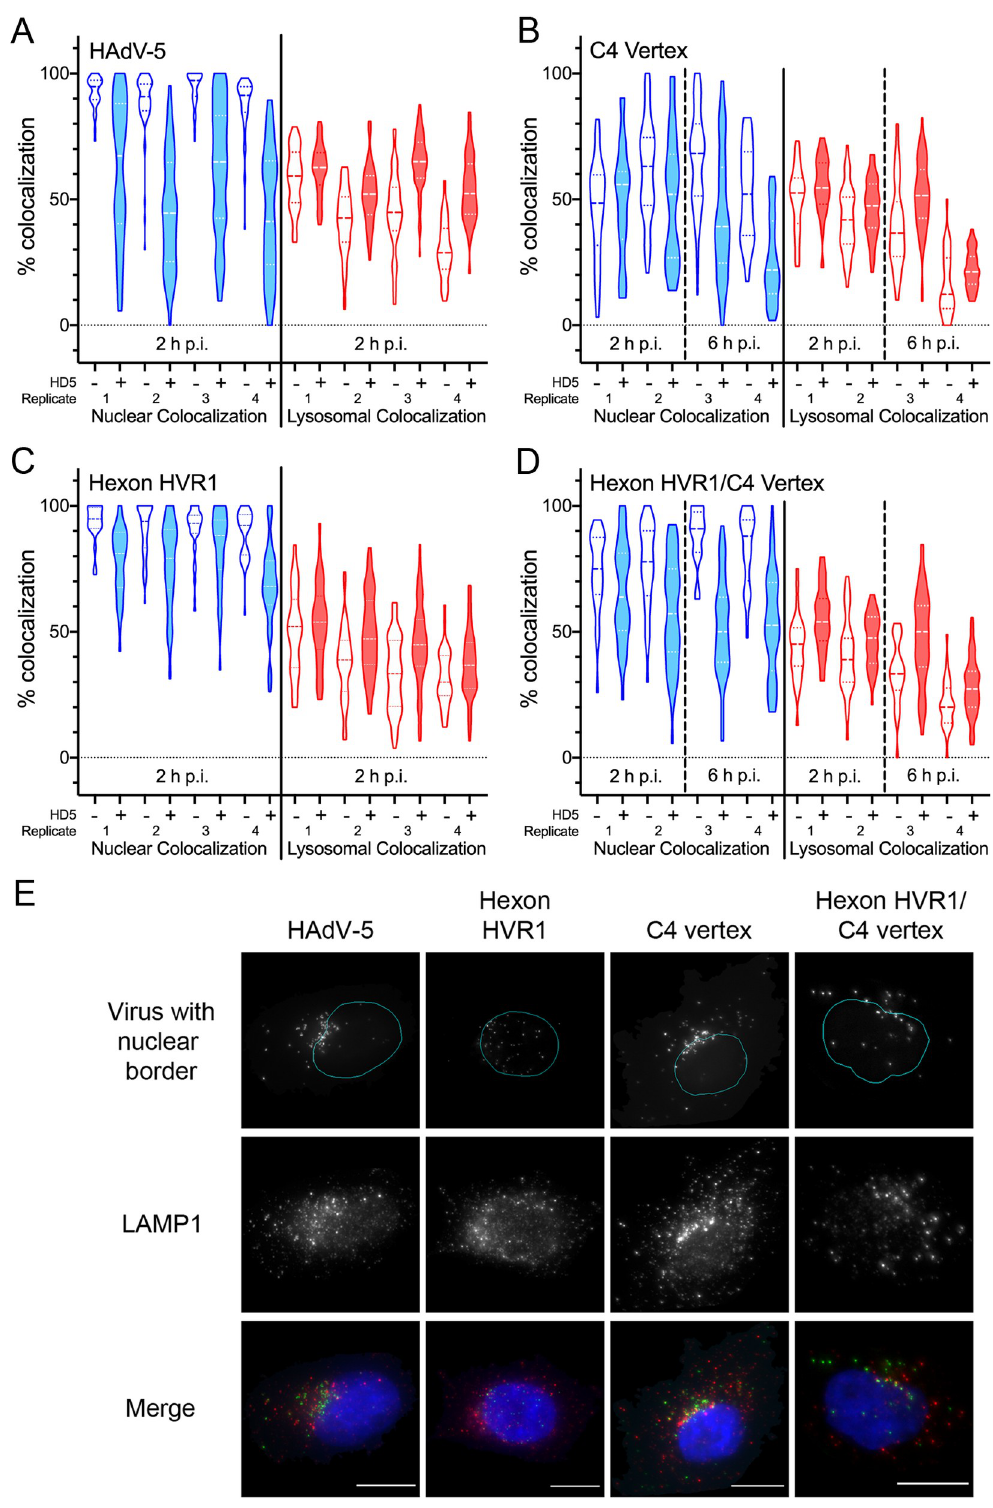
Fig 8. HD5 neutralization correlates with a reduction in nuclear localization. AF488-labeled HAdV-5 (A), C4 vertex (B), hexon HVR1 (C), and hexon HVR1/C4 vertex (D) were bound to A549 cells in the cold and then incubated with (shaded plots) or without (unshaded plots) 10 μ M HD5 (as in Fig 4, protocol 2). Cells were then warmed to 37˚C and fixed at the